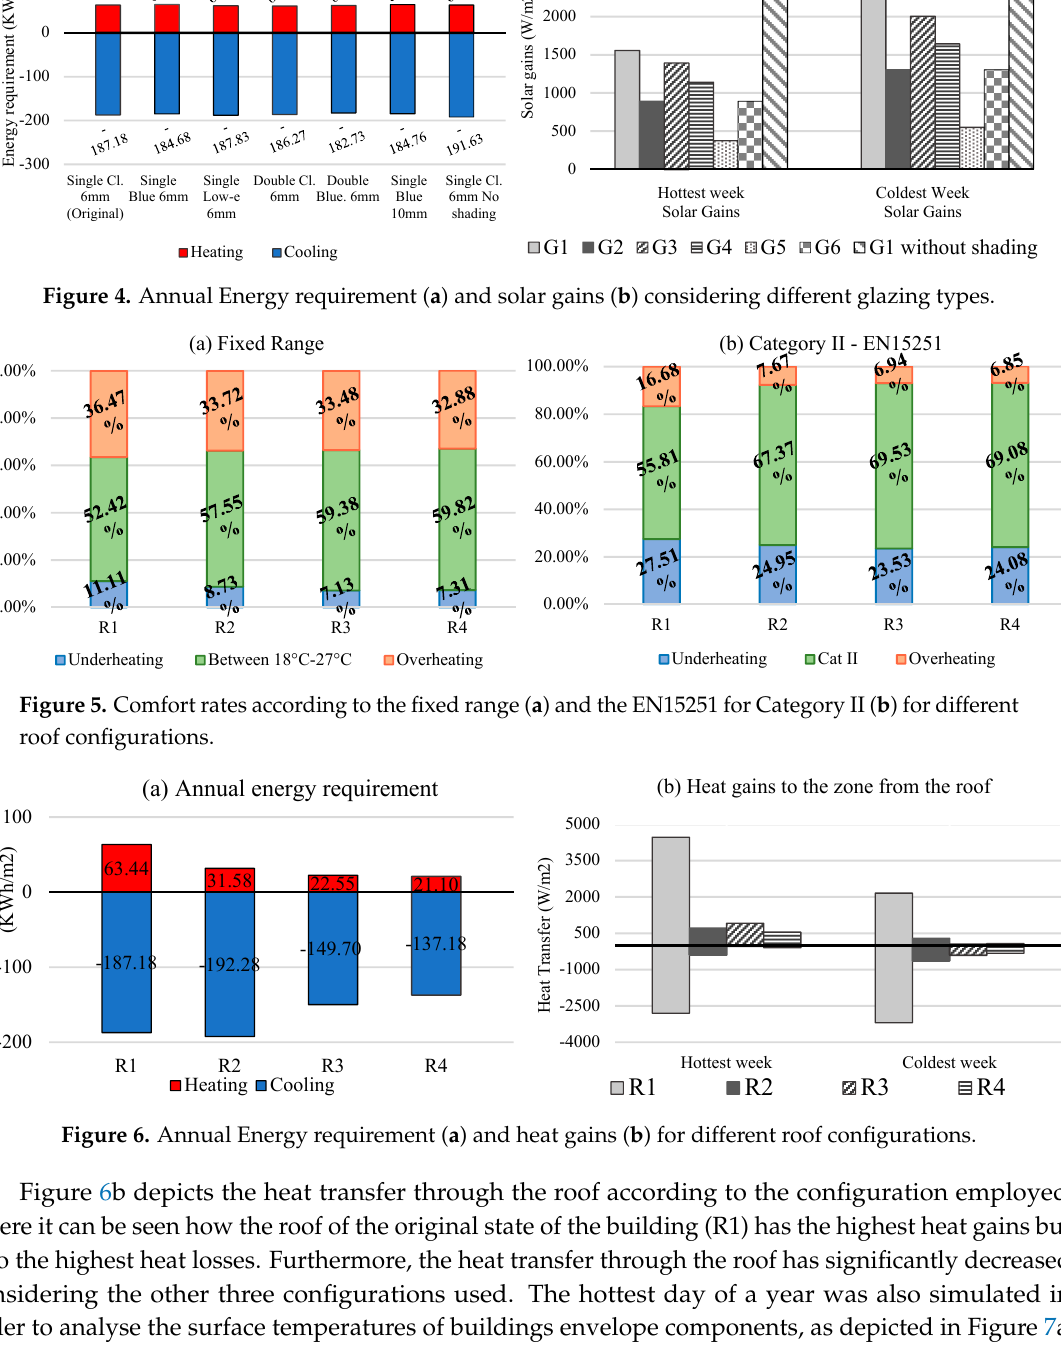
Figure 7. Surface temperatures for the roof in the original state R1 ( a ) and for the solution R4 ( b ).